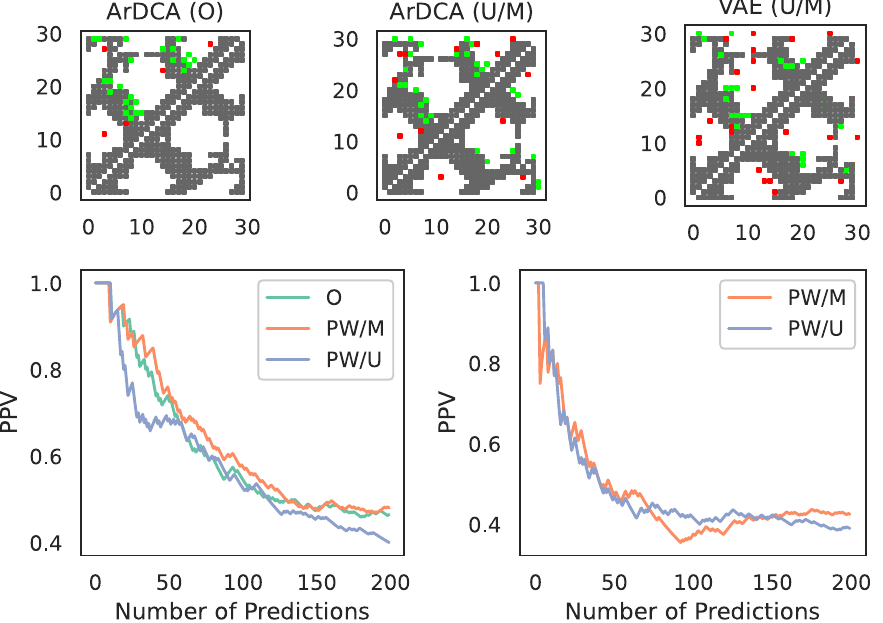
Fig 9. Contact prediction on YAP1 using extracted models. Top Row : Contact predictions vs. ground truth for the top N = 30 predicted contacts for models extracted from ArDCA and the VAE (weight decay setting 0.01). Horizontal and vertical axes show positions. True contacts are grey, true positives are green, and false positives are red. The upper parts show the contacts for models extracted with the uniform distribution, the lower parts show the same for models extracted with the original model distribution. The left-most plot shows the contact predictions for ArDCA from the original method in [9]. Bottom Row: PPV plots for the top 200 predictions for the original ArDCA model and the extracted pairwise model for ArDCA (left) and the VAE (right). The plots shows the fraction of true positives in dependence of the number of top predictions taken into account.